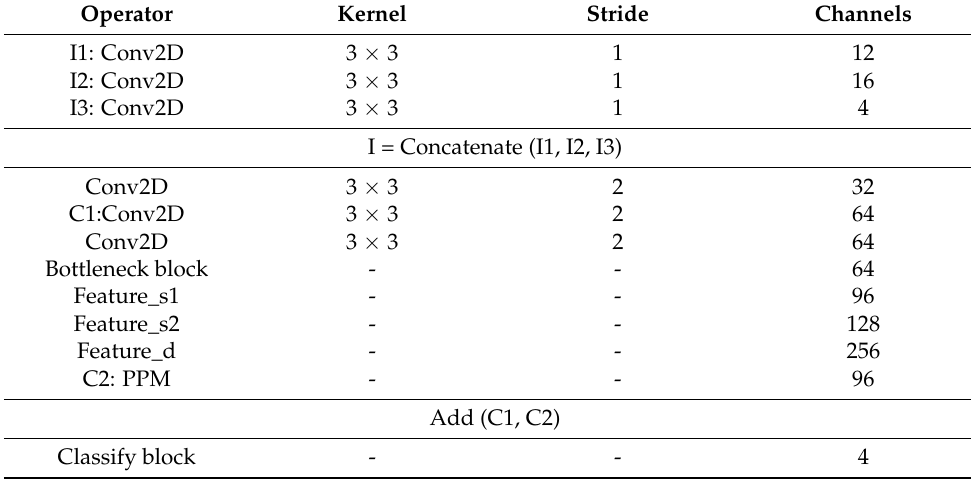
Table 7. Details of stage